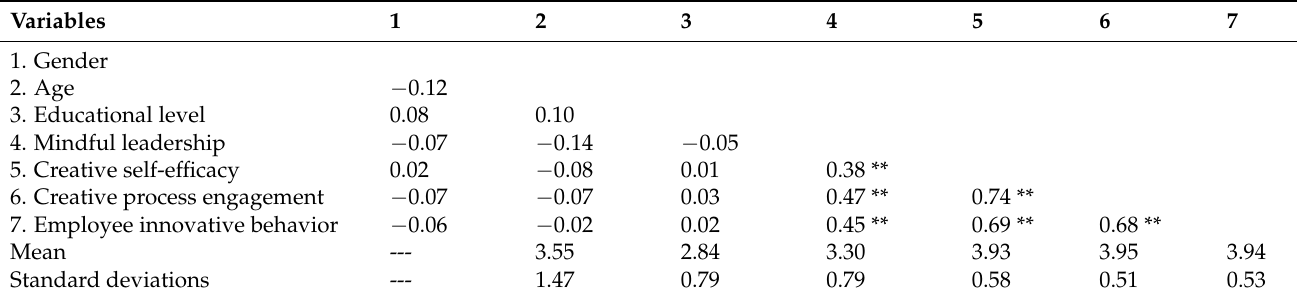
Table 2. Means, standard deviations, and